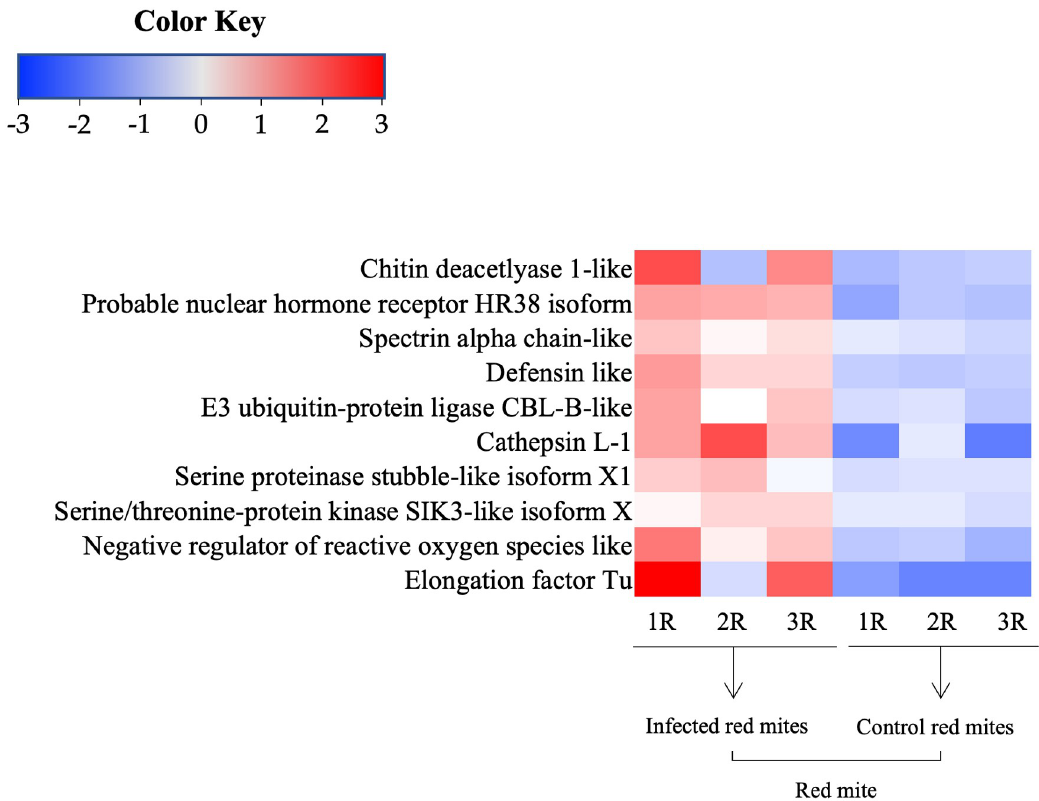
Fig 6. Heatmap of red mite immune-related genes. Heatmap of immune-related genes of red mite by significant genes annotated with e-values lower than 1E-20.